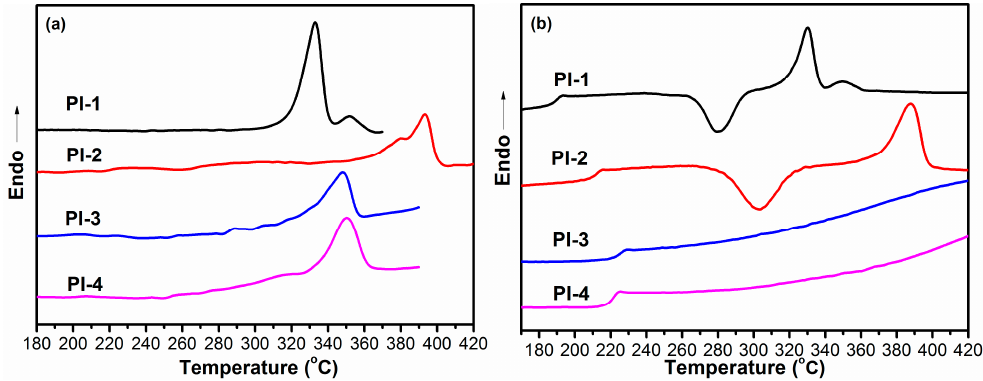
Figure 3. DSC curves for HQDPA polyimides: ( a ) first heating; ( b ) second heating.